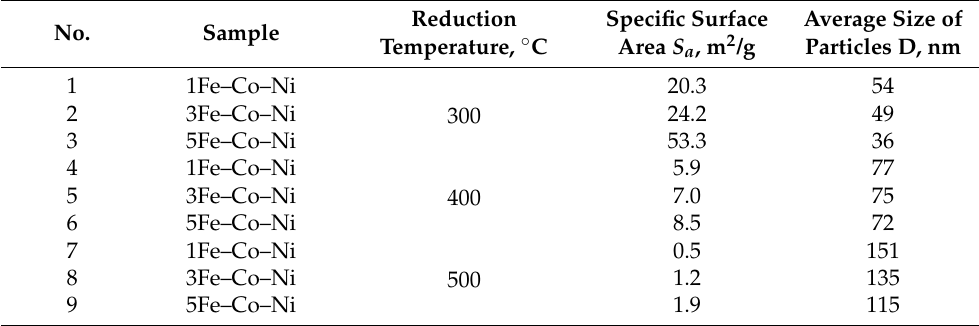
Table 2. Results of measuring the specific surface area and the average particle size by the Brunauer– Emmett–Teller (BET)